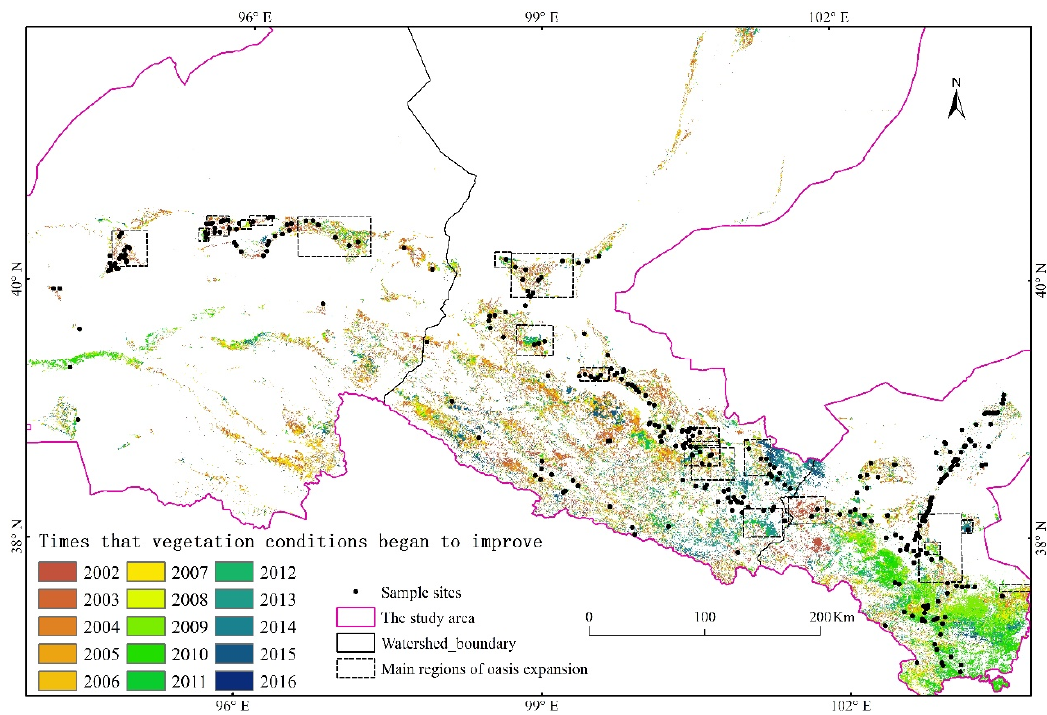
Figure 5. The time that vegetation conditions began to improve in the Hexi region. Areas in the black dotted frames represent the main regions of oasis expansion obtained from previous local study [57].